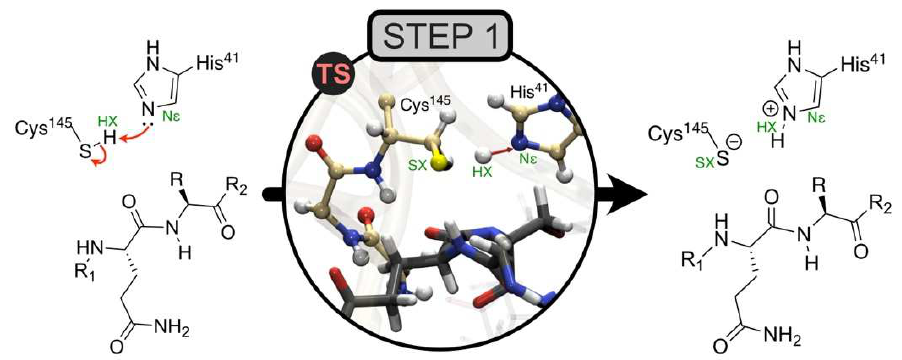
Figure 5. Step 1 of the catalytic mechanism of the SARS-CoV-2 main protease. Transition state image of the active site studied by QM/MM methods in [20]. Adapted with permission from Ref. [20]. 2022, Springer Nature.